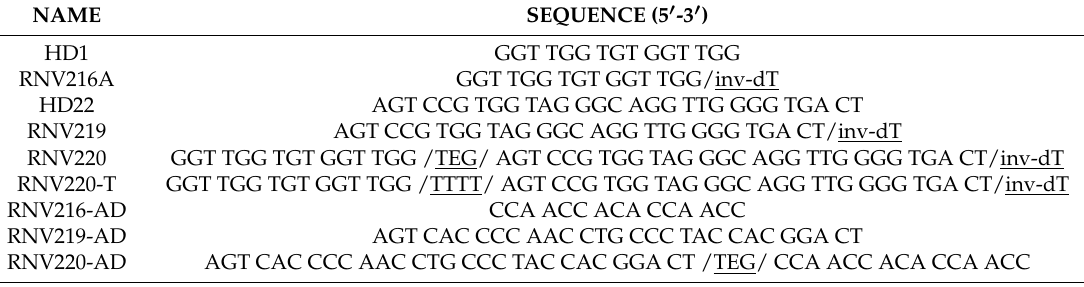
Figure 1. Structural representation of DNA, 3 ′ -inverted monomer and triethylene glycol (TEG) linkage used in this study. B, nucleobase. Table 1. Aptamer and antidote sequences used in our analysis. The chemical modifications are underlined.